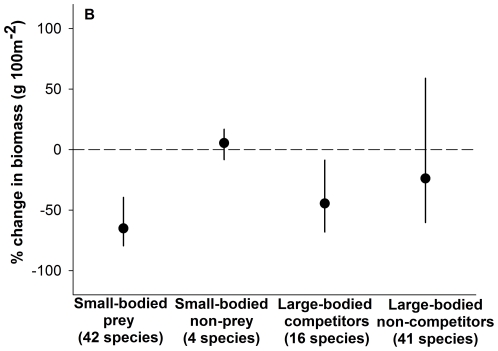
The percent change in biomass of native fishes between 2008 and 2010 on New Providence, Bahamas coral reef sites.Points represent medians, bounded by parametric bootstrapped 95% confidence intervals. The dashed line indicates no change in biomass.